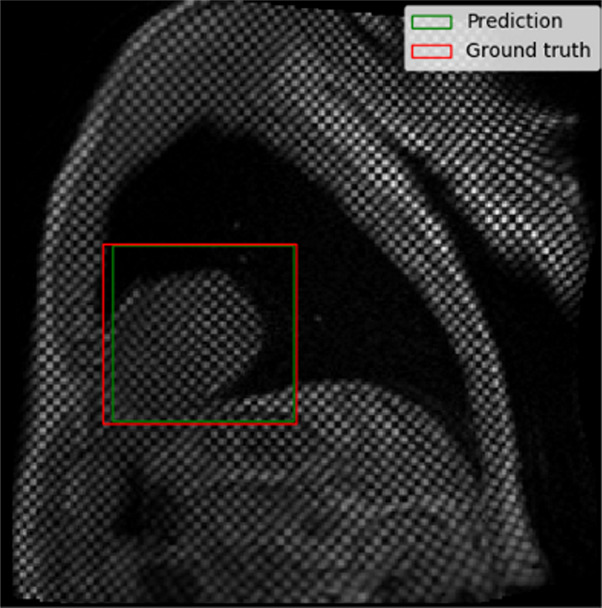
Example results from the localization network. (a) Intersection over union (IoU) of 53% and (b) IoU of 63% are the worst prediction results within the test set. (c, d) Typical prediction results. (e) Histogram shows the distribution of accuracy (IoU) throughout the test set.